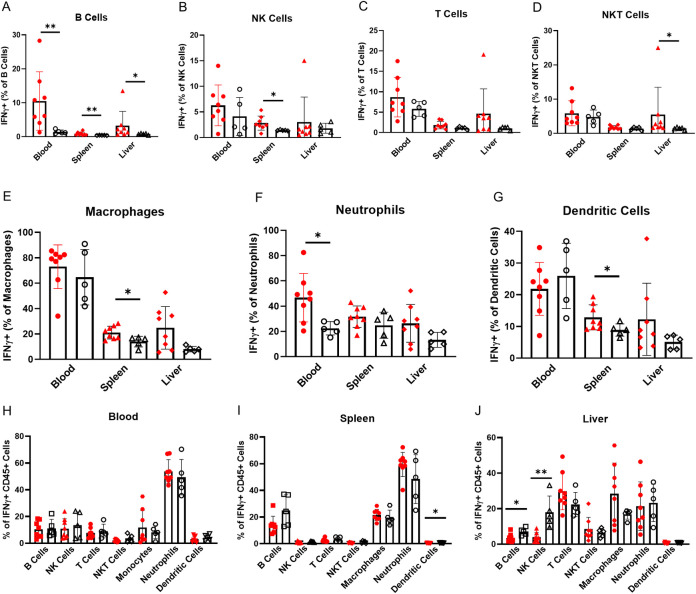
IFN-γ expression is increased in alcohol dependent compared to control mice.(A-G) Expression of IFN-γ by (A) B cells, (B) NK cells, (C) T cells, (D) NKT cells, (E) macrophages, (F) neutrophils and (G) dendritic cells in alcohol dependent (red, solid fill) and non-dependent (black outline, white fill) mice. (H-J) Immune cells as percentages of all IFN-γ producing CD45+ cells in (H) blood, (I) spleen and (J) liver isolated from dependent and non-dependent mice. *, p<0.05; **, p<0.01 analyzed by Mann-Whitney U test; n = 5–8.